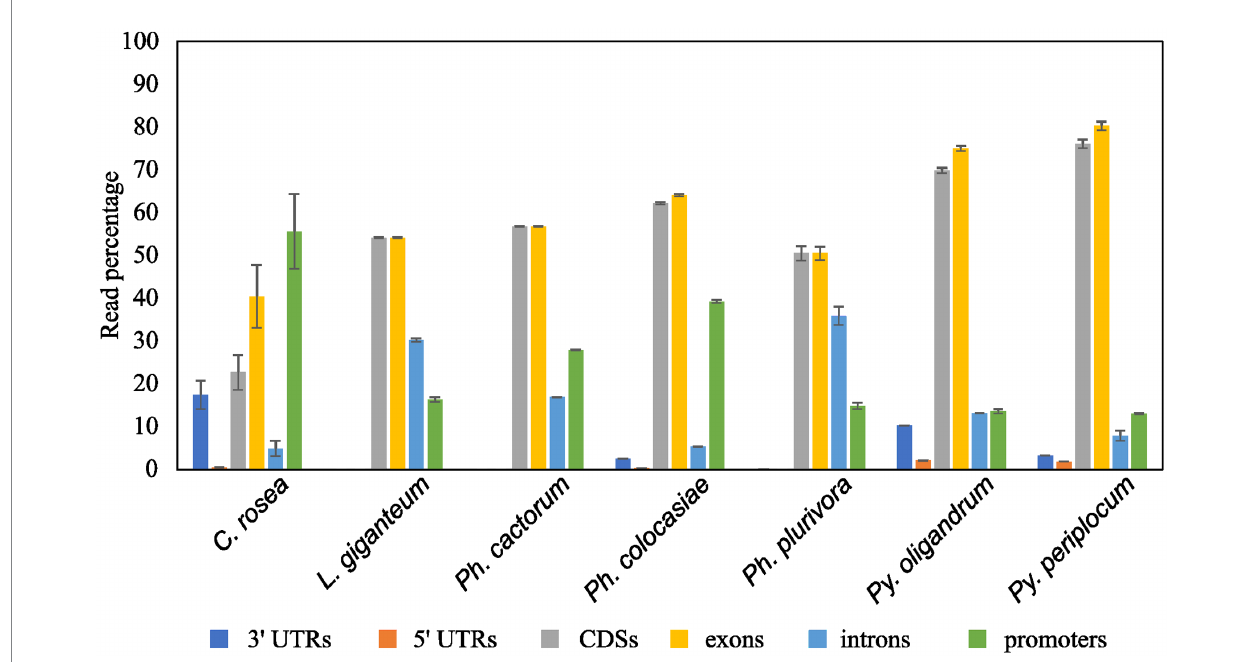
FIGURE 4 Proportion of sRNA reads mapped to different genic locations of the respective species. Error bars indicate the standard deviation between the replicates. The percentage is calculated on the total number of reads mapping to genes.